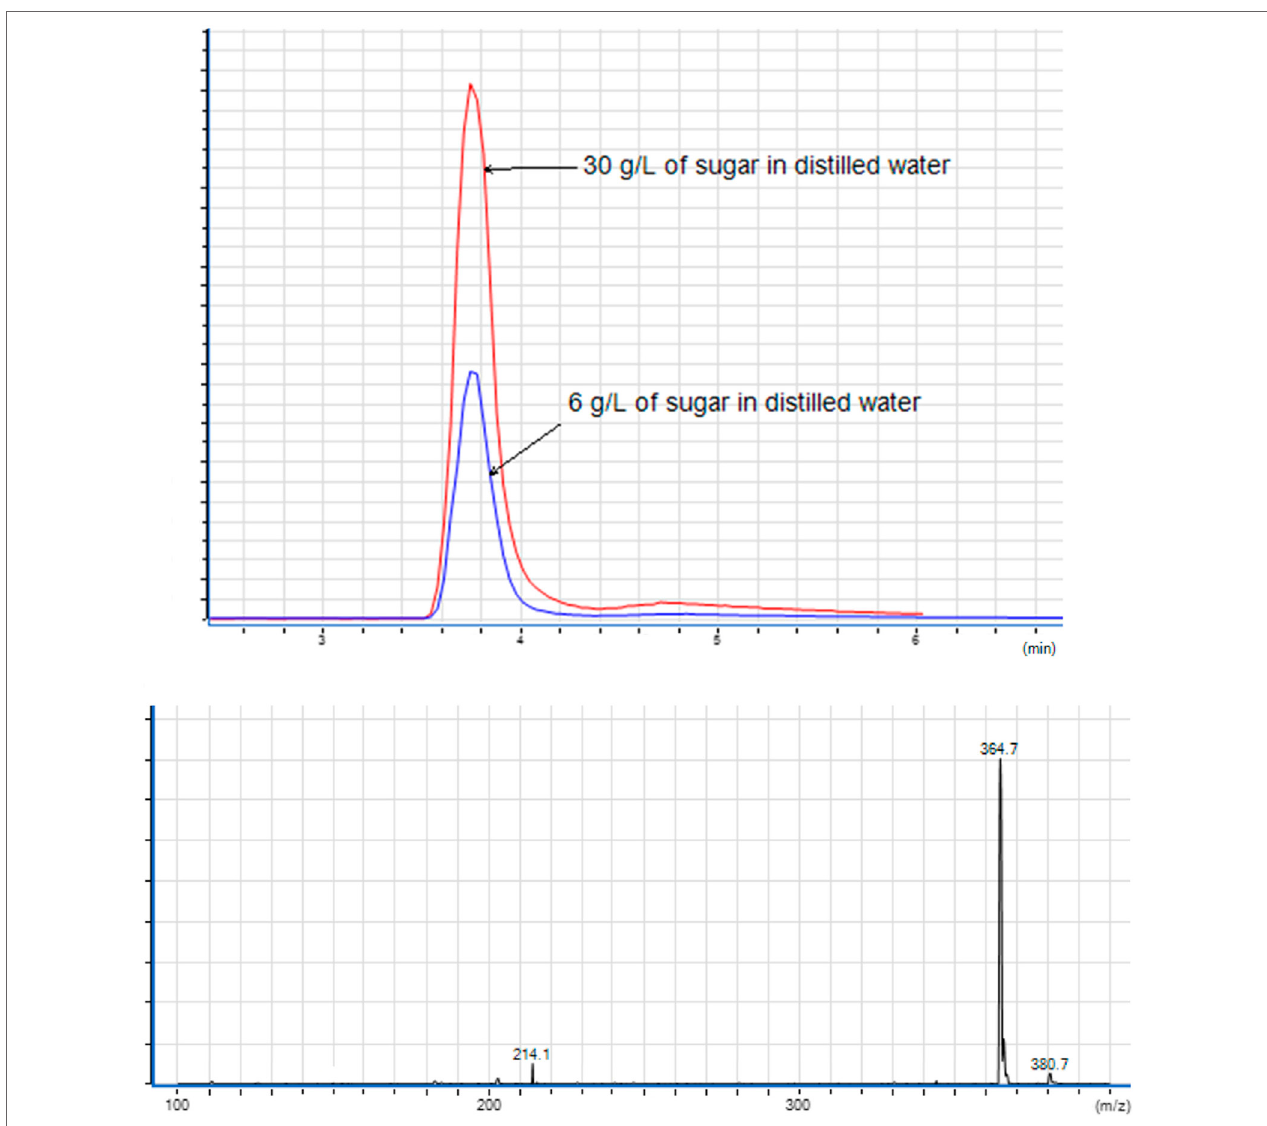
FigUre 3 | Extracted ion chromatogram of solutions with 6 and 30 g L − 1 of sugar and mass spectrometry spectrum of 365